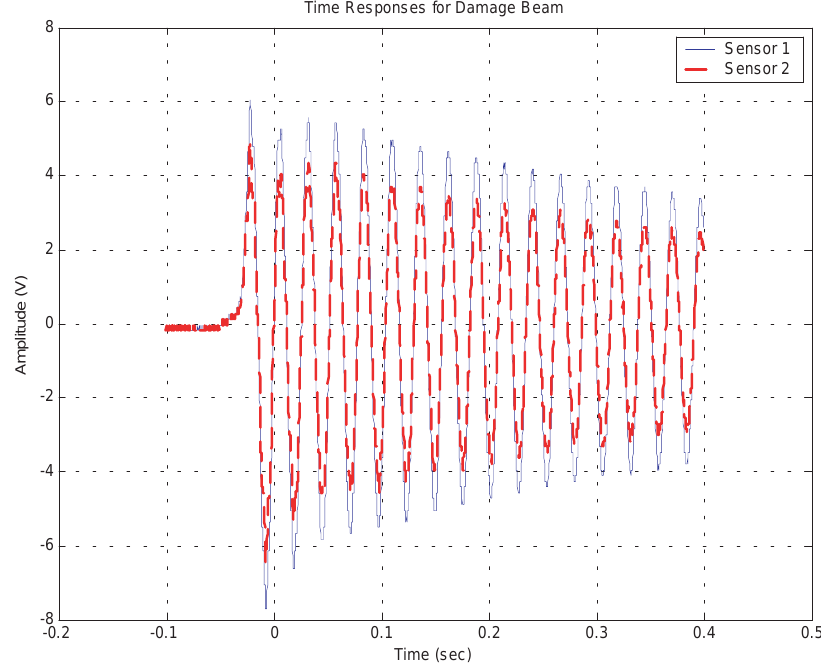
Fig. 8. Transient time responses for sensors S1 and S2 on the damage beam. (a) Wavelet Transform from sensor 1 for the damage beam. (b) Wavelet Transform from sensor 2 for the damage